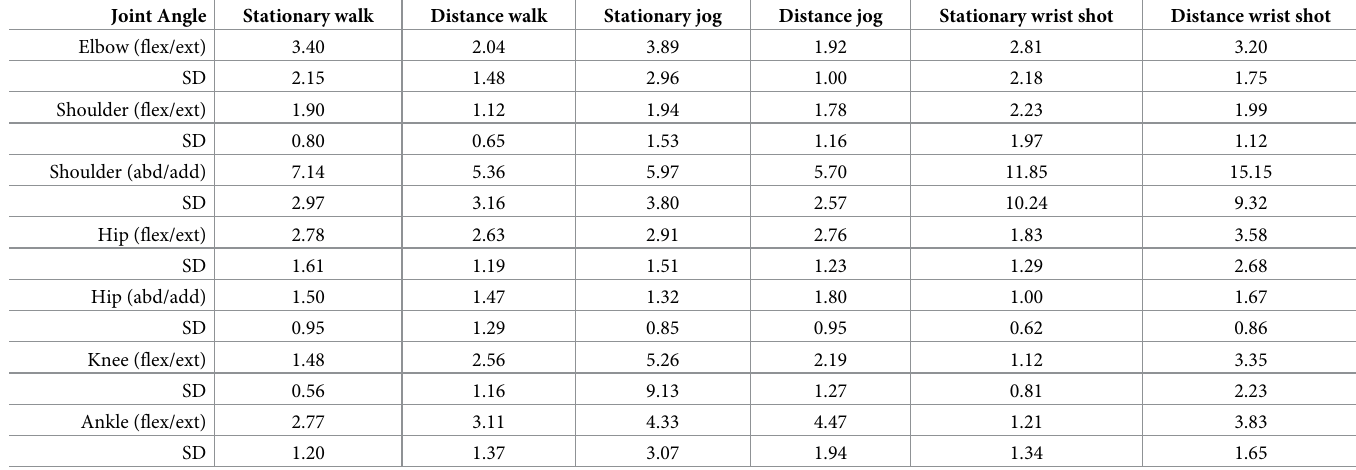
Table 4. RMSE comparison between PNS and VICON for raw values for all movements.